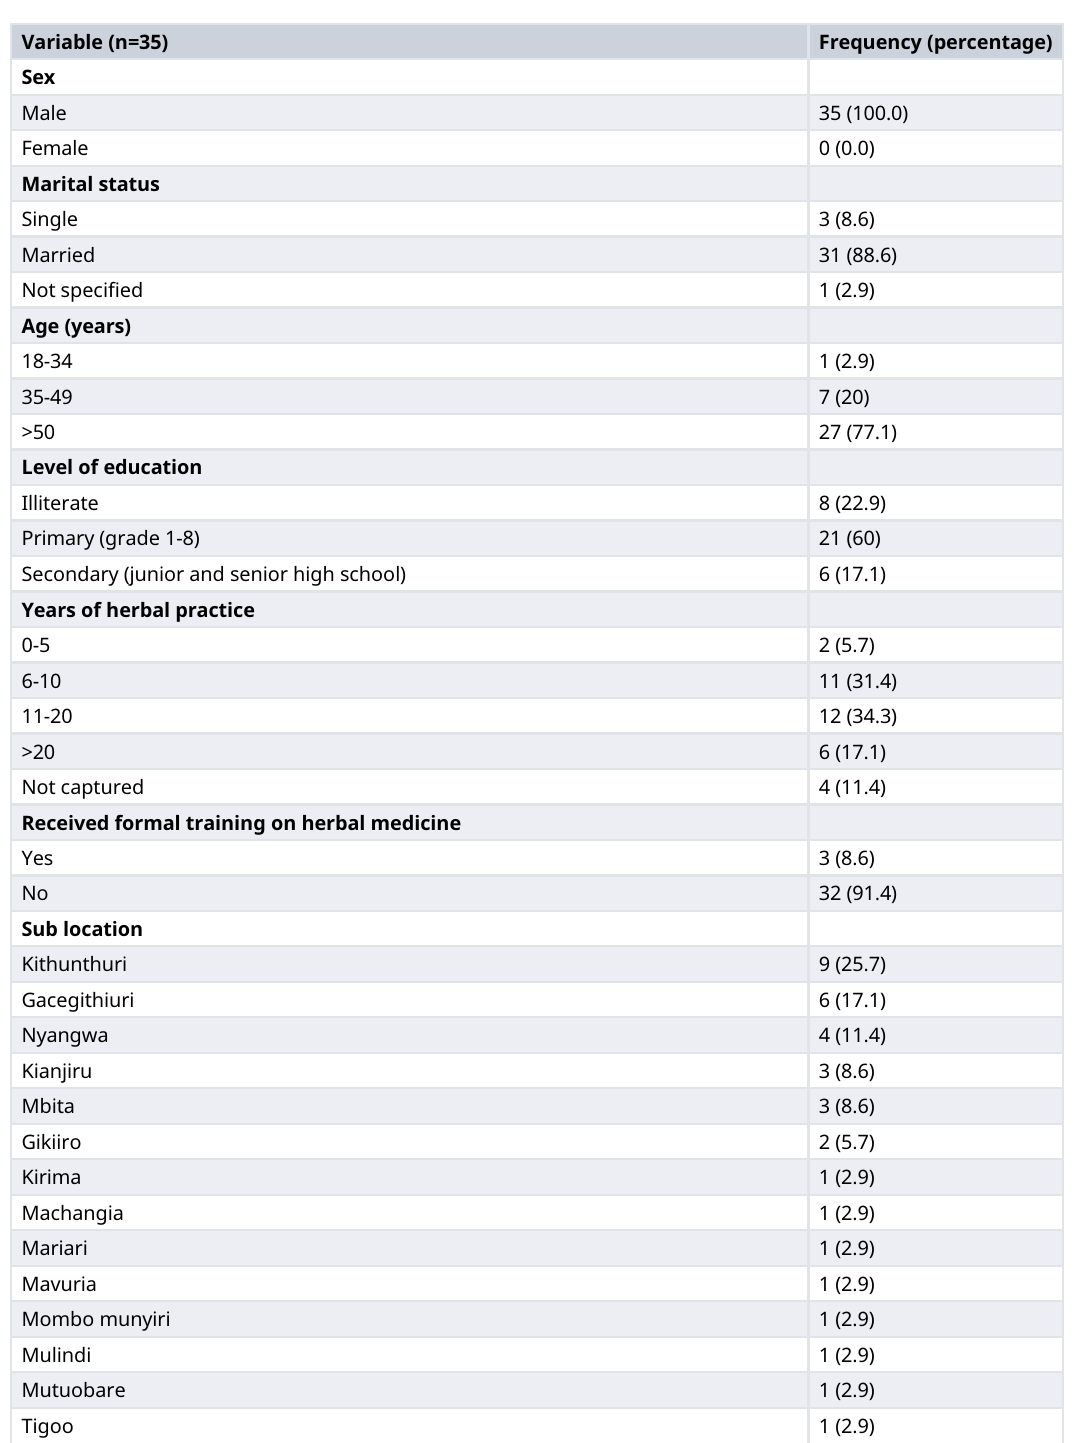
Table 1. Demographic characteristics of herbalists interviewed in Embu County